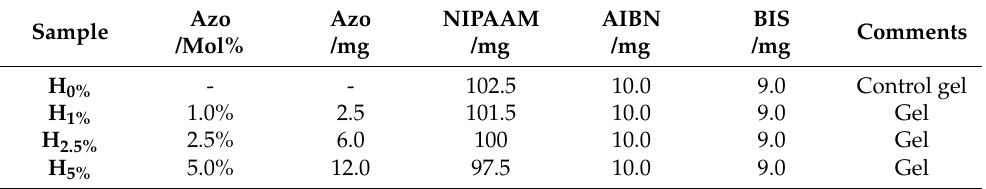
Table 1. Formulations for the control PNIPAAm and Azo-co-NIPAAm